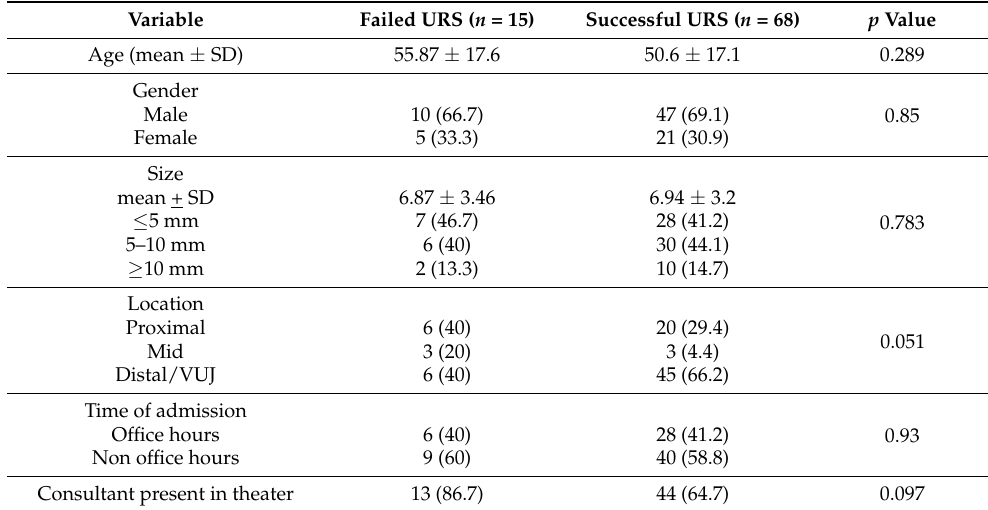
Table 2. Univariate analysis of comparing successful and failed